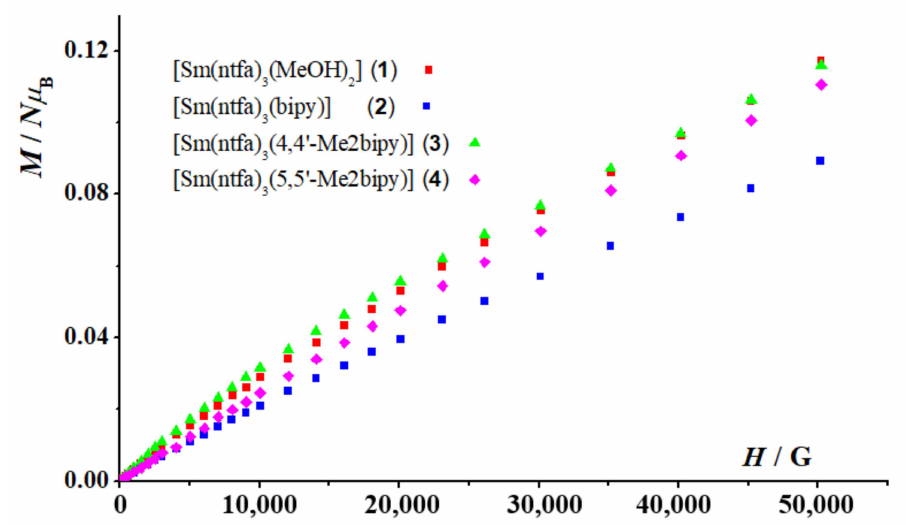
Figure 7. Magnetization plots measured at T = 2 K (field dependence of 1 – 4